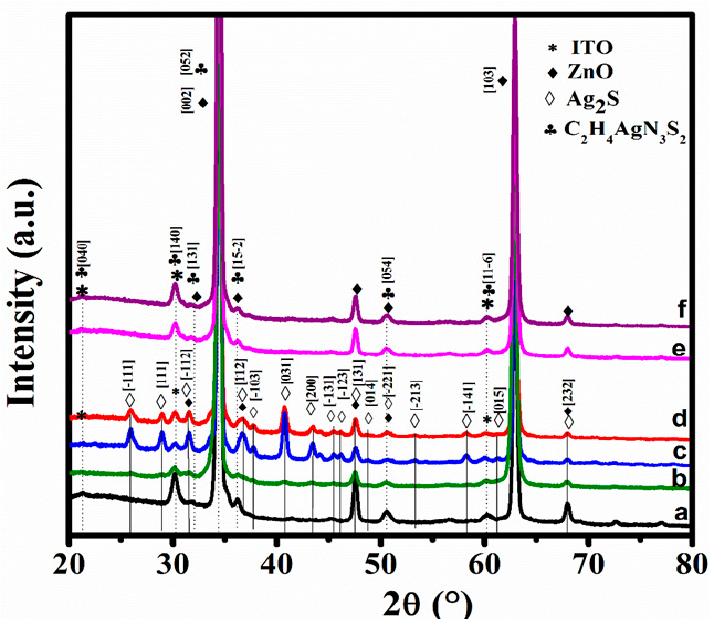
Figure 6. X-ray diffractogram of ZnO NRs ( a ), Ag 2 S/ZnO NRs/ITO with various concentrations of CS(NH 2 ) 2 : ( b ) 0.01 M; ( c ) 0.03 M; ( d ) 0.05 M; ( e ) 0.08 M; and ( f ) 0.1 M.